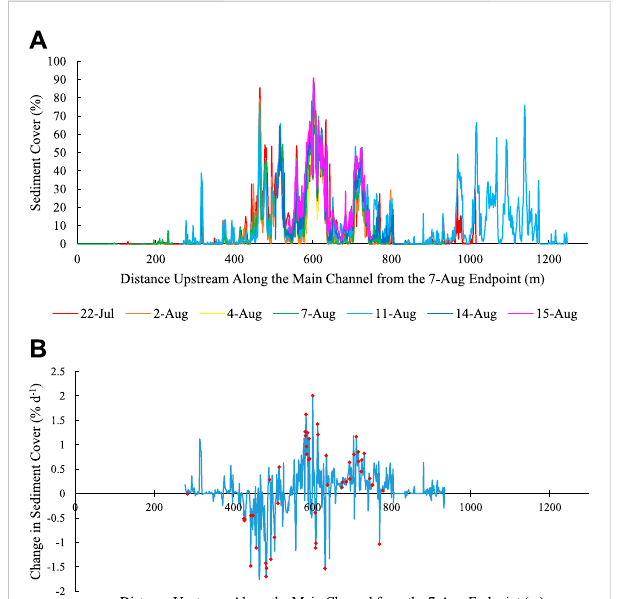
FIGURE 3 (A) Sedimentcoverwithineach1-mzonealongthemainchannel foreach fl ight.Distancesarerelativetothe fl owpathdistancetothe7- Aug stream endpoint (c.f. Figure 1). (B) The rate of change in sediment cover (slope of the linear regression of sediment cover, % d − 1 ) for each 1-m zone of the main channel with at least three observations. Sections of the stream where the change in sediment cover was statistically signi fi cant ( p < 0.05), are indicated with red dots. On average, sediment cover of the main channel increased by 0.07% per day.